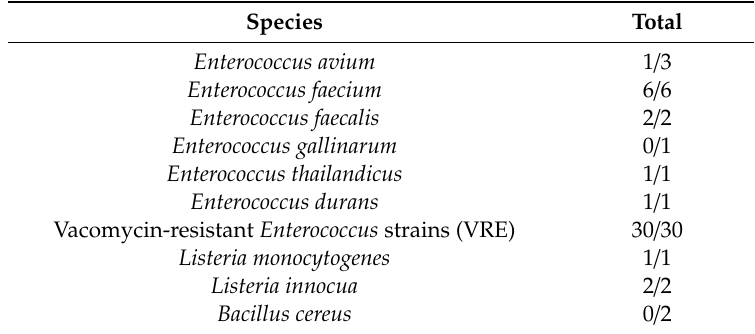
Table 3. Spectrum of activity of bacteriocin produced by E. faecium ST10Bz showing the number of sensitive strains out of the total tested for a specific species.